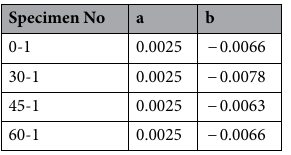
Table 2. Fitting parameters between strain and